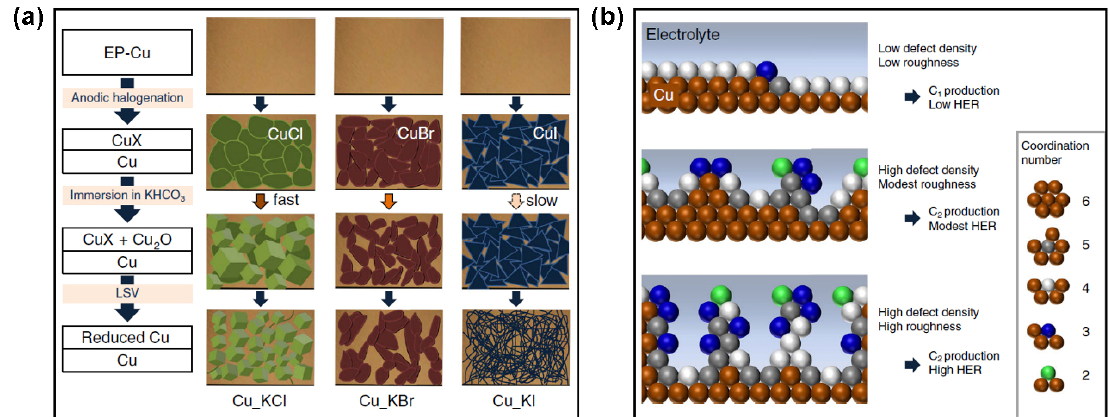
Figure 2 Schematic diagram of the synthesis process and morphology of electro-derived Cu-based catalysts. (a) Schematic diagram of the anodic halogenated synthesis. (b) Active sites coordination and two-dimensional visualization and corresponding results in the CO 2 RR process. Reproduced with permission from Ref. [7], © Kim, T. et al.